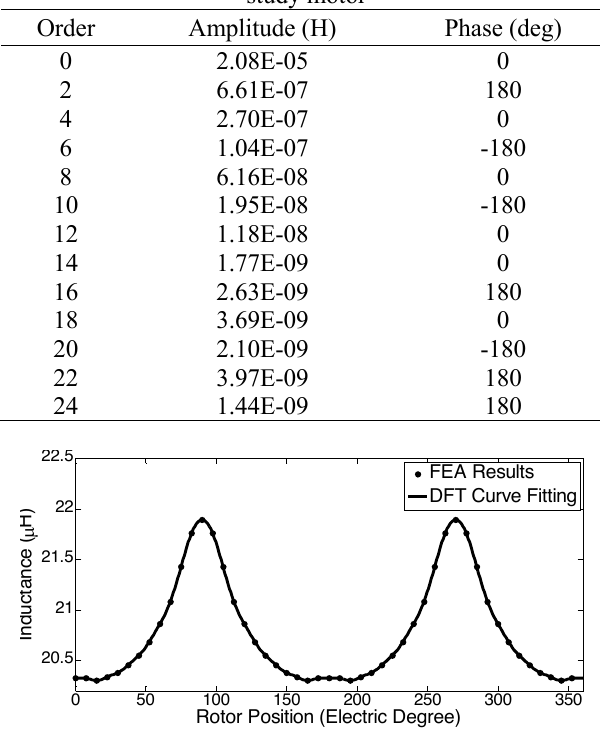
Figure 6: Self-inductance of phase 'a' versus rotor position. self-inductances of the windings and the back emfs are the only parameters required for modeling and analyzing a multi- phase TFPM machine performance.